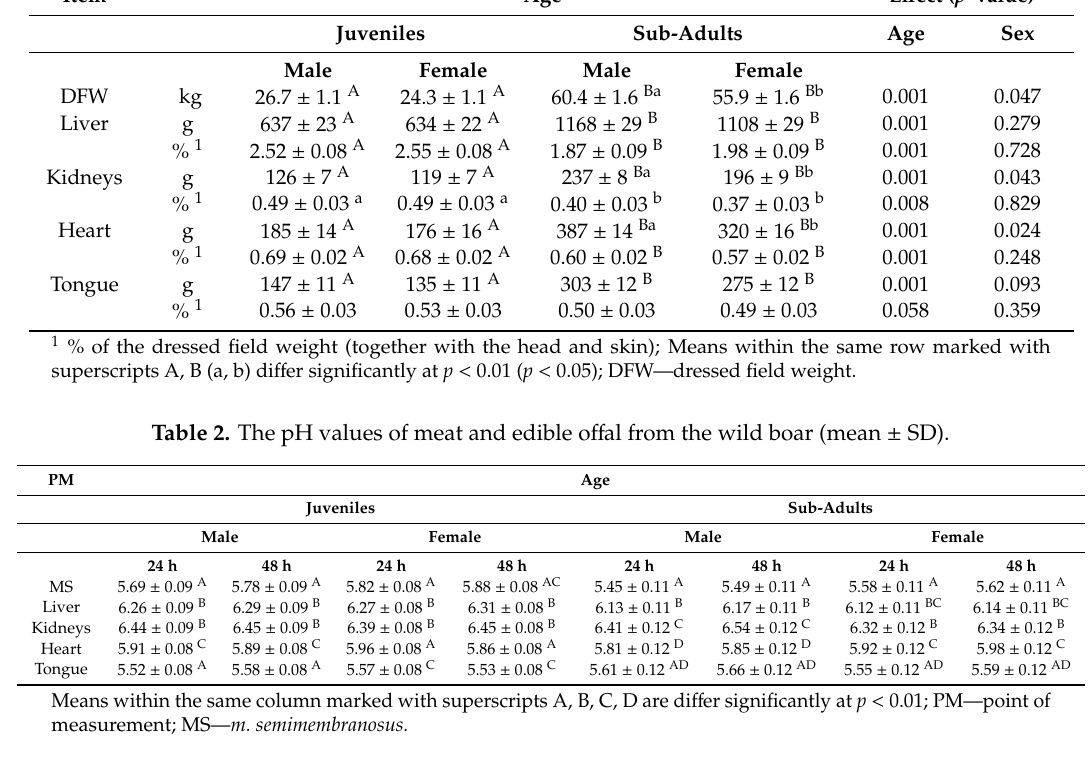
Table 1. The dressed field weight, mass and proportion of edible o ff al of the wild boar (mean ± SD). Item